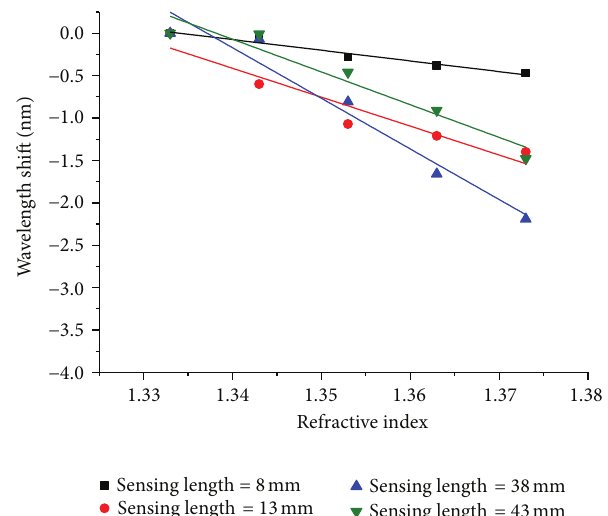
Figure 13: Refractive index measurement results for the reduced 𝐿 range.